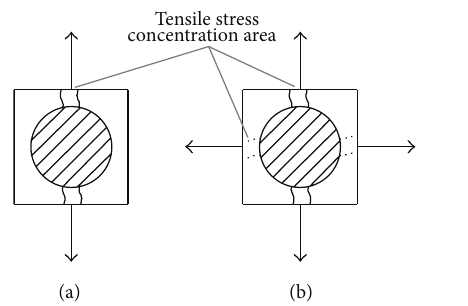
= ultimate strain, and ult